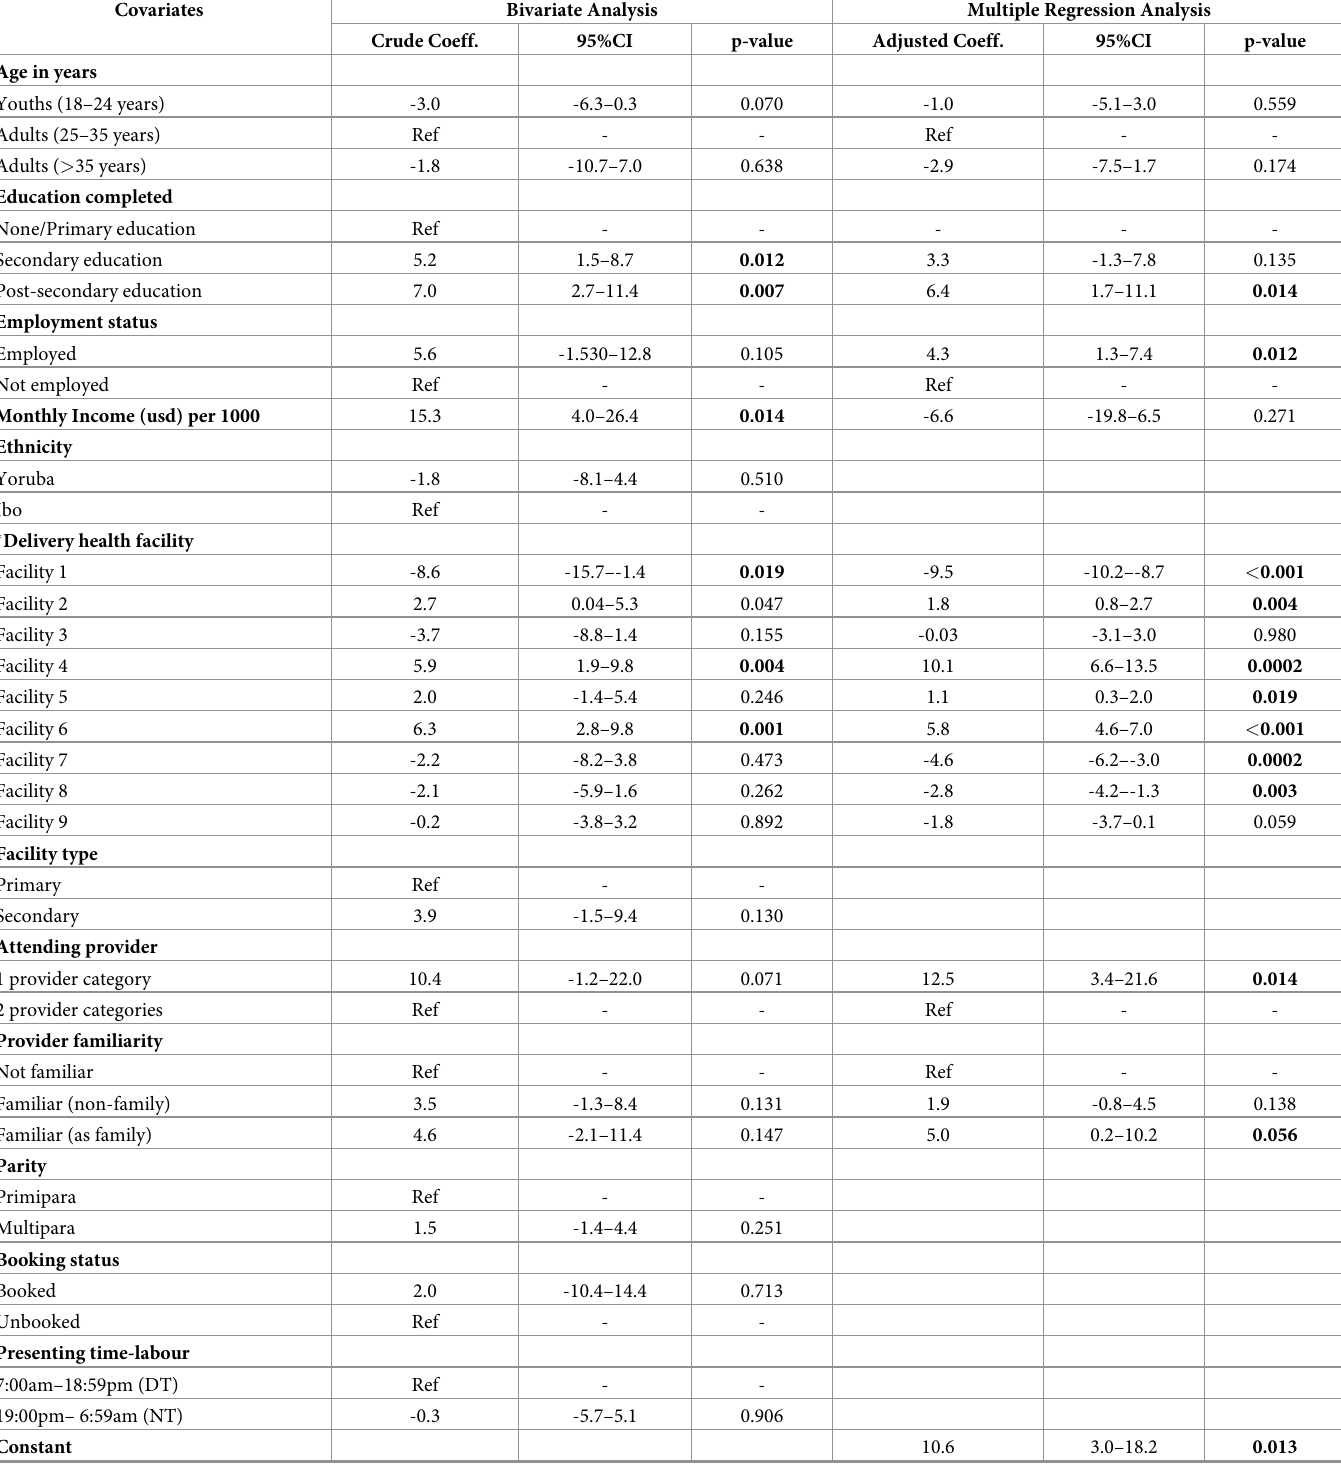
Table 6. Factors associated with observed RMC scores during